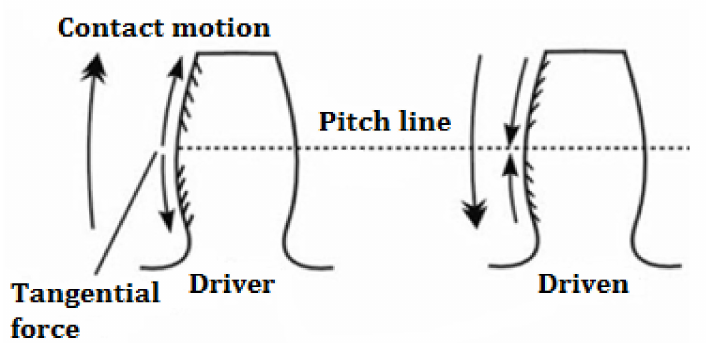
Figure 1. Illustration of direction of growth of micro cracks on the gear teeth from reference [19].